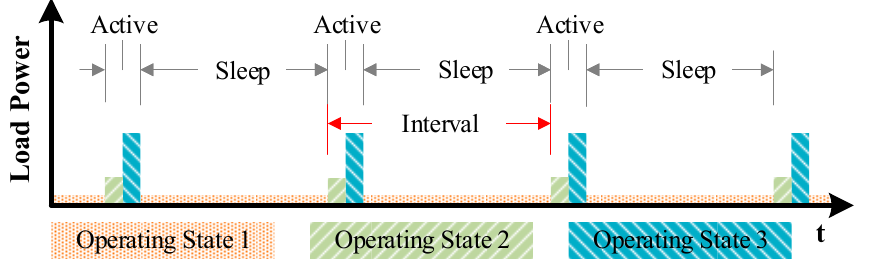
Figure 1. Load behavior with multiple operating states, repeated with a schedule/interval.